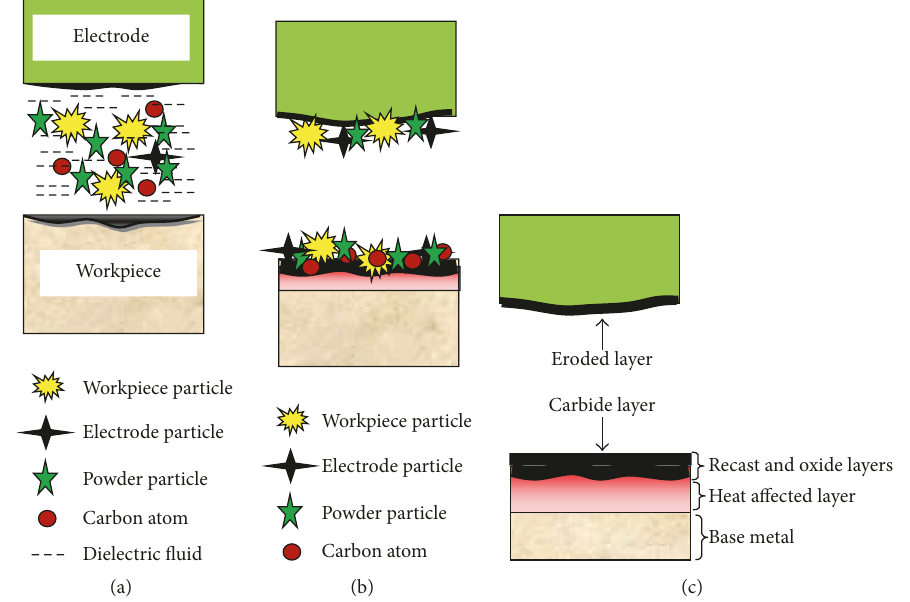
Figure 17: Mechanism of material migration and deposition. (a) Initiation of spark. (b) Carbon atoms, powder, and tool-electrode particles adhered on the electrodes surfaces. (c) Formation of three distinct